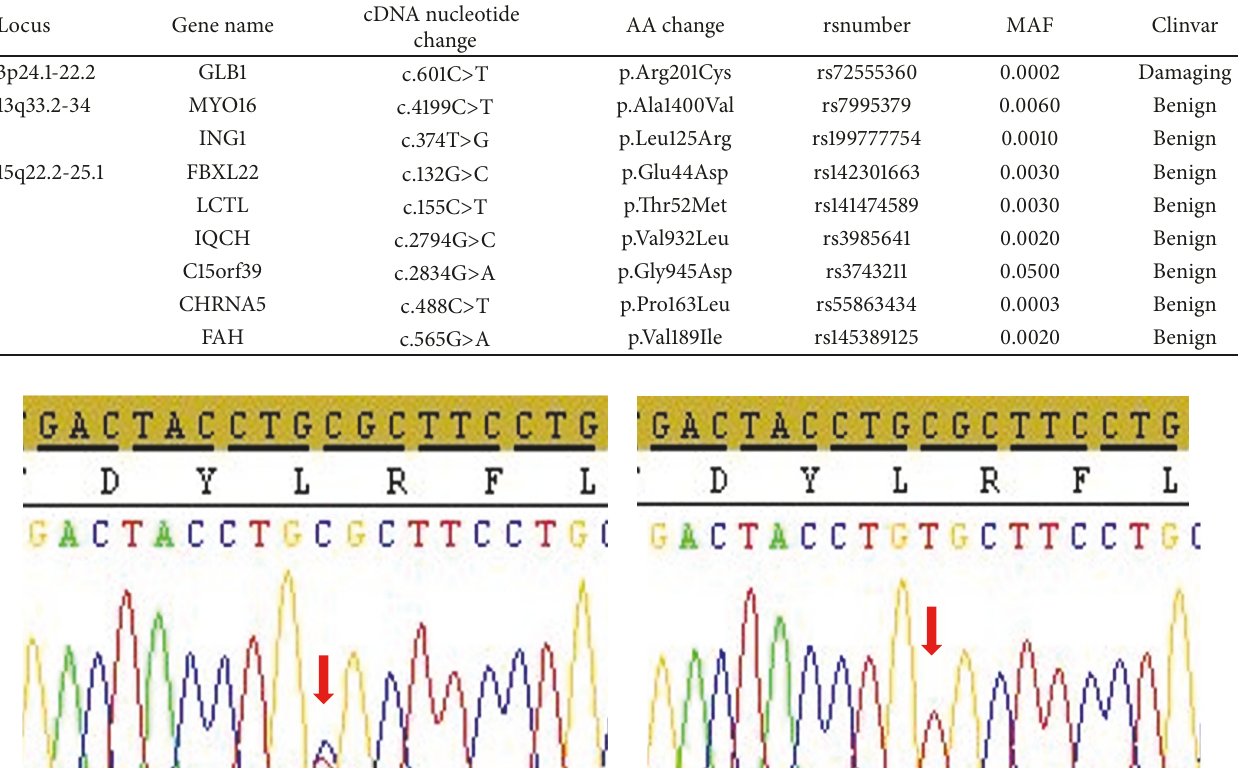
Table 1: List of low frequency functional variants in the three linked ROH regions. Locus